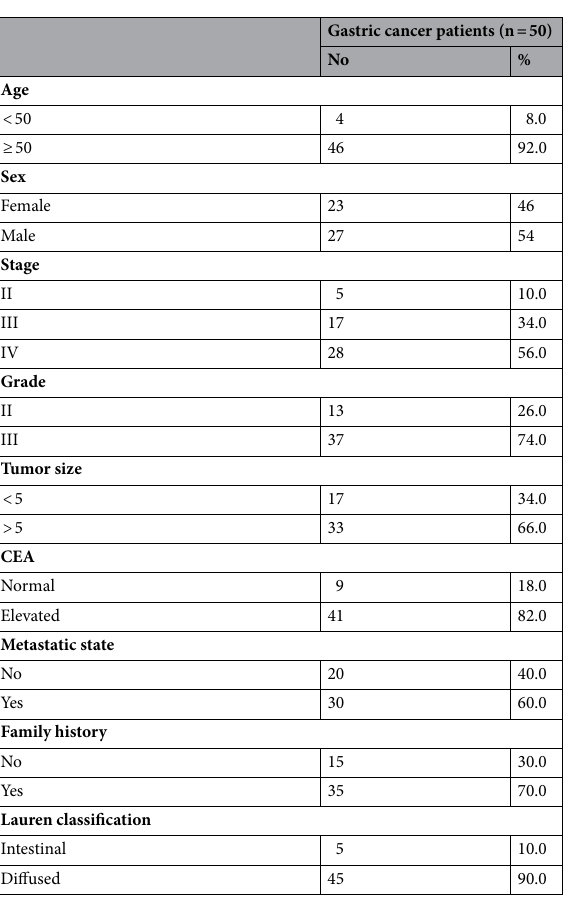
Table 1. Clinicopathological characteristics of gastric cancer patients. n : number of